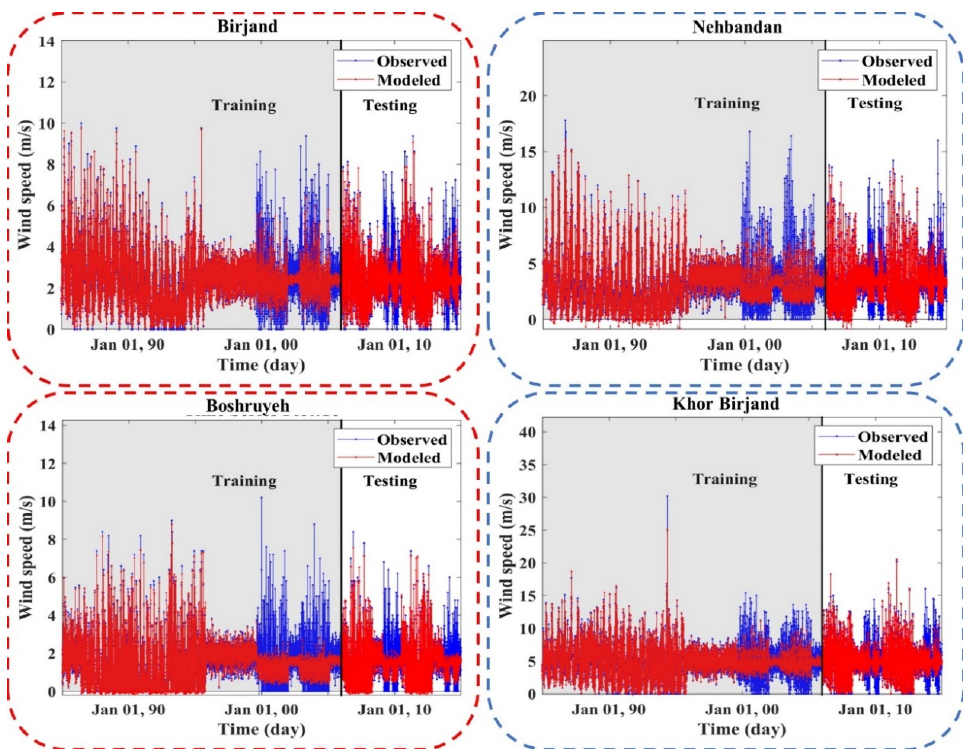
Figure A3. Time series of observed and modeled values of WS using the meta-algorithm at different stations.